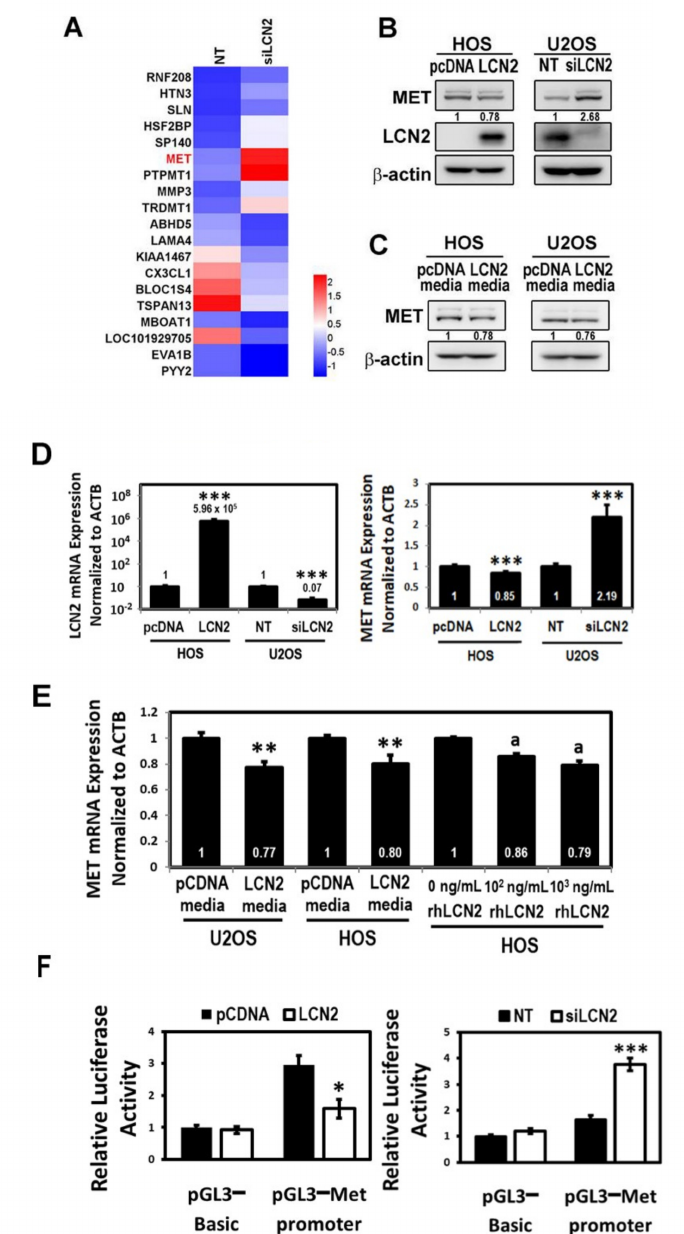
Figure 3. RNA sequencing for siLCN2 U2OS cells and effects of LCN2 on MET in HOS and U2OS cells. ( A ) Heat map of the hierarchical clustering of 19 differentially expressed genes identified in U2OS cells after siRNA directly against the LCN2 expression for 24 h. ( B ) Western blot analyses for the LCN2 and MET expressions in HOS cells after transfection with vectors containing a constitutively active LCN2 cDNA and U2OS cells after siRNA directly against the LCN2 expression were conducted. ( C ) Western blot analyses for the MET expression in both U2OS and HOS cells treated with culture media of LCN2 overexpression HOS cells were conducted. ( D ) RT–PCR for LCN2 and MET mRNA expressions in HOS cells after transfection with vectors containing a constitutively active LCN2 cDNA and U2OS cells after siRNA directly against the LCN2 expression were measured and subsequently subjected to quantitative analysis. *** p < 0.001 compared with the vehicle group. ( E ) RT–PCR for the MET mRNA expression in both U2OS and HOS cells treated with culture media of LCN2 overexpression HOS cells and HOS cells treated with various concentrations (0, 100, and 1000 ng/mL) of recombinant human LCN2 were measured and subsequently subjected to quantitative analysis. ** p < 0.01 compared with the vehicle group. F: 12,791, p < 0.01. a Significantly different, p < 0.05, when compared with control. ( F ) HOS cells were transfected with pcDNA vector for overexpression of LCN2 and U2OS cells were transfected with siRNA inhibiting human LCN2 for 24 h and then subjected to luciferase assay to analyze the promoter activity of MET. * p < 0.05, *** p < 0.001 compared with the vehicle